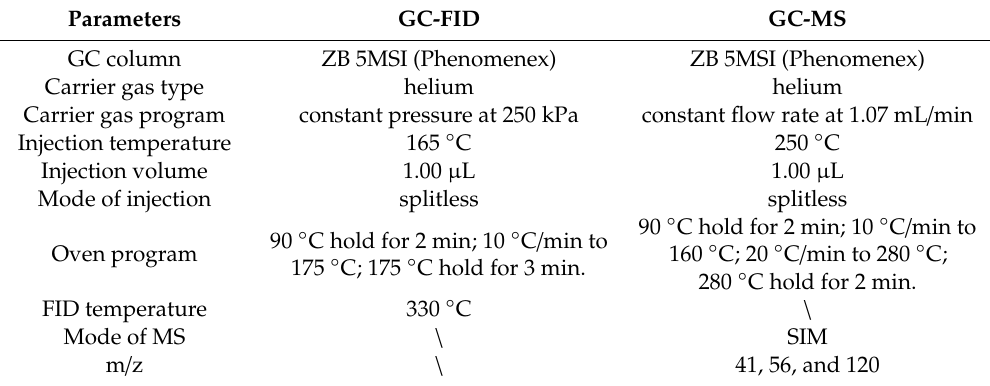
Table 3. Parameters setting for gas chromatography equipped with flame ionization detector (GC-FID) and GC equipped with mass spectrometry (GC-MS).